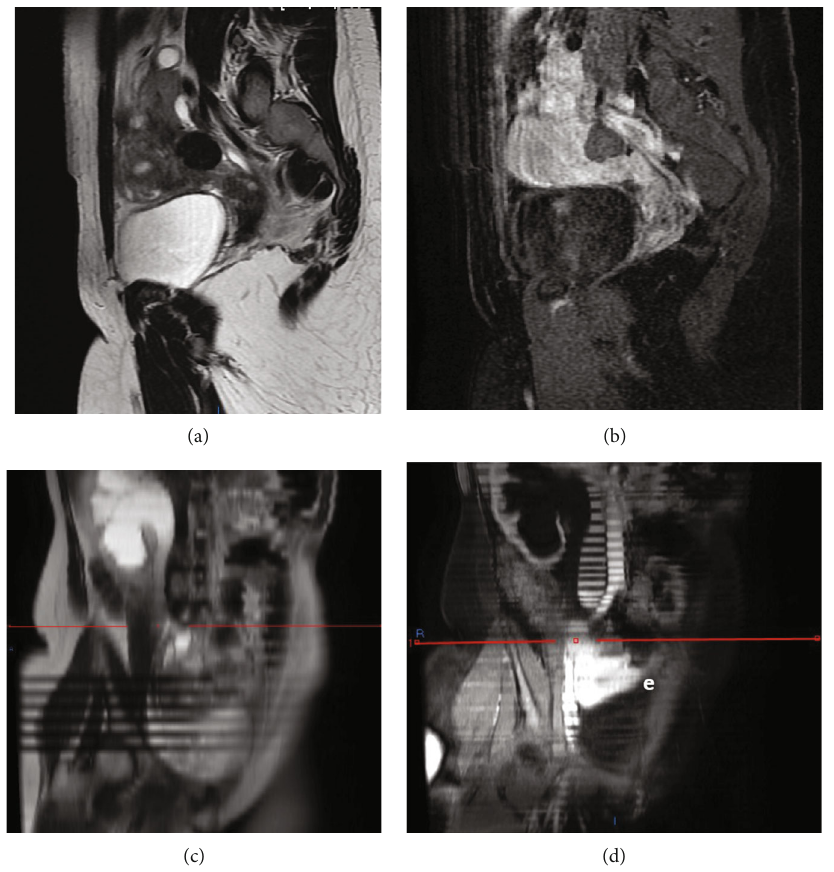
Figure 1: Pelvic magnetic resonance imaging showing the following: (a) sagittal T2-weighted spin-echo image: a round mass with very low homogeneous signal intensity in its central part is present; (b) sagittal 90 second postgadolinium T1-weighted fat-suppressed spin-echo image: the upper aspect of the mass enhances re fl ecting active disease and the nodular desmoid tumor exhibits minimal enhancement con fi rming its fi brous nature; (c) paracoronal T2-weighted; and (d) postgadolinium T1-weighted images showing right kidney hydronephrosis due to an extraureteral obstruction con fi rmed to be a desmoid tumor.